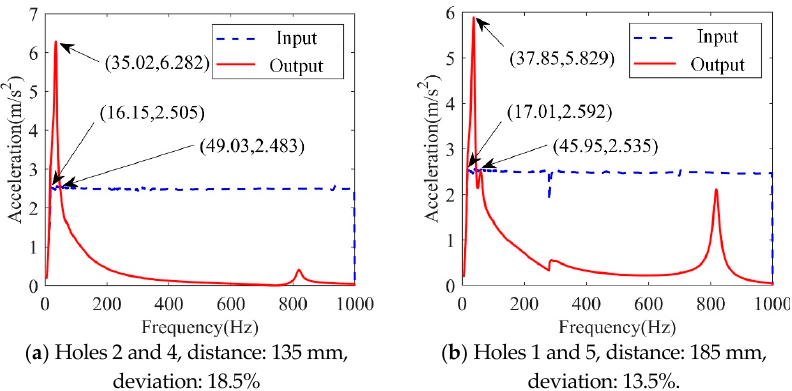
Figure 14. Experimental curves of the dynamic frequency sweep for vibration isolation systems with different distances.